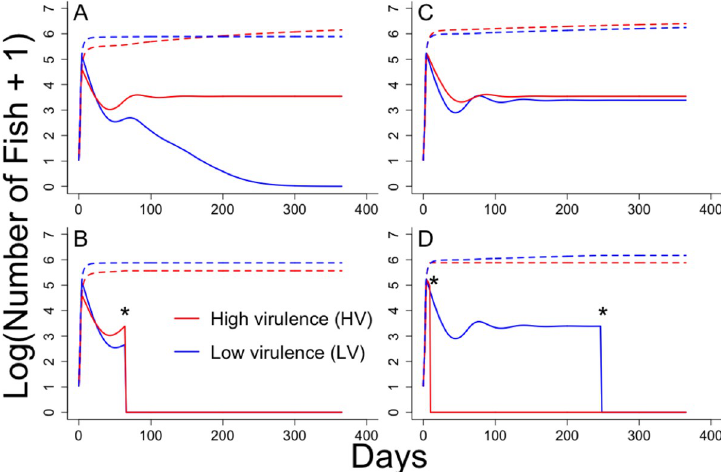
Fig 6. Model output of IHNV transmission at a population level. Plots show incidence (solid line) and cumulative total (dashed line) number of fish (Log + 1) infected with either the high virulence (HV–red) or low virulence (LV– blue) IHNV genotype, through time (days). Data are derived from an SIRD (susceptible, infectious, recovered, dead) model (see methods Eqs 1–4) parameterized from experimental data (see Table 1). For panels A and B, populations of fish are simultaneously infected with both genotypes HV and LV, and thus both lines represent the same fish population. For panels C and D, populations of fish are singly infected with each genotype separately, and thus each line represents a different fish population. For panels B and D, culling is implemented when mortality reaches 30% of the initial fish population size. Culling involves removal of all fish from the population, regardless of infection status (i.e. set S, I, R, and D to zero). Culling events are denoted by � on the figure. State variables are initially set to S = 200,000, infected HV = 10, infected LV = 10, R = 0, D = 0; to reflect conditions in a raceway on a standard trout farm (Table 1).